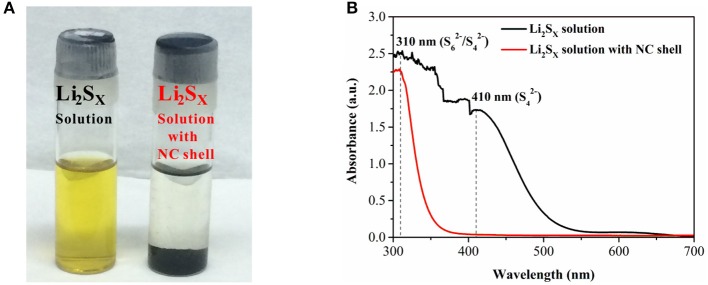
(A) Adsorption properties of NC shell in Li2S6 solution; (B) UV–Vis absorption spectra after adding NC shell.